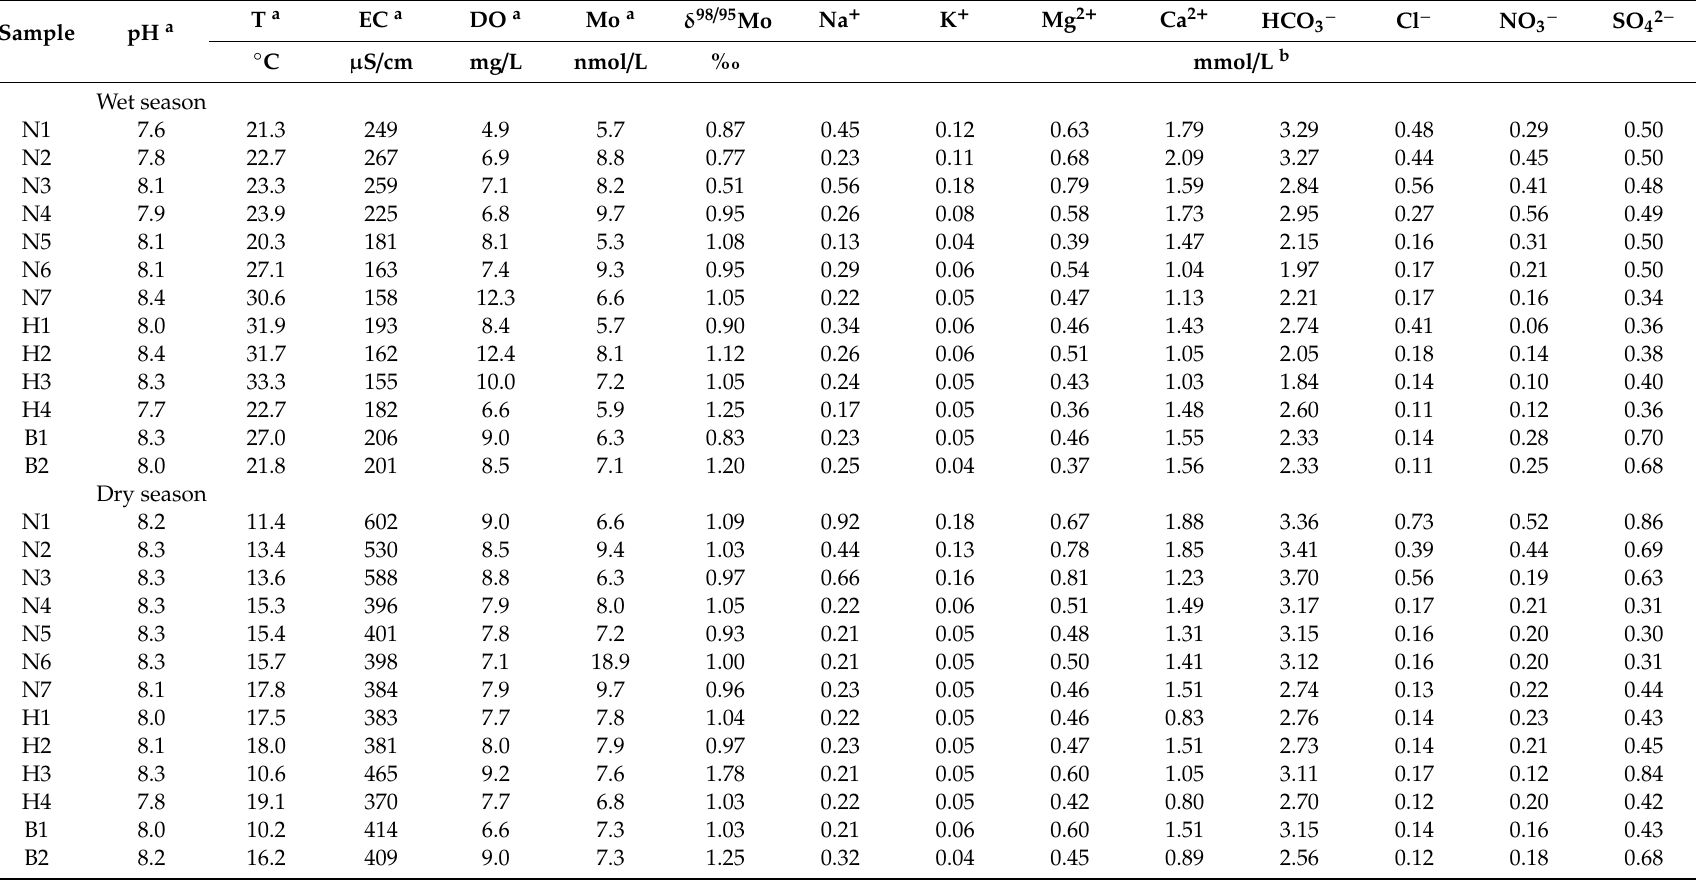
Table 1. Hydrological parameters, Mo concentrations and δ 98 / 95 Mo, major ions of the upper Xijiang River